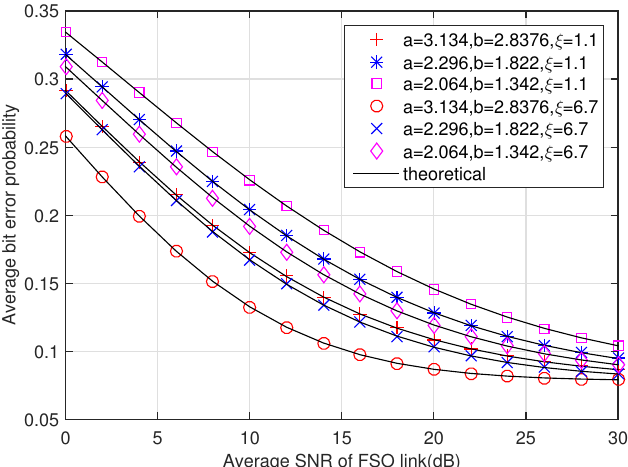
Figure 8. Average bit error probability under different turbulence and pointing error conditions with IM/DD detection, where Q =